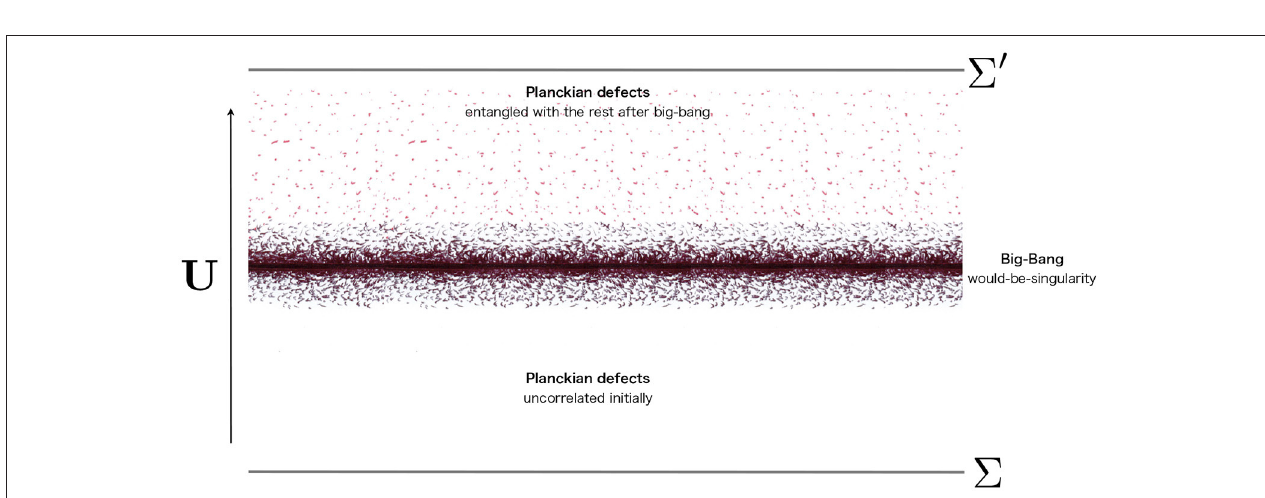
FIGURE 2 | Diagram (effectively) illustrating the natural scenario, suggested by the fundamental features of LQG, for the resolution of the information puzzle in black hole evaporation (Perez, 2015). As in Figure 1 , one should keep in mind the limitations of this kind of spacetime representation of a process that is fundamentally quantum and hence only understandable in terms of superpositions of different spacetime